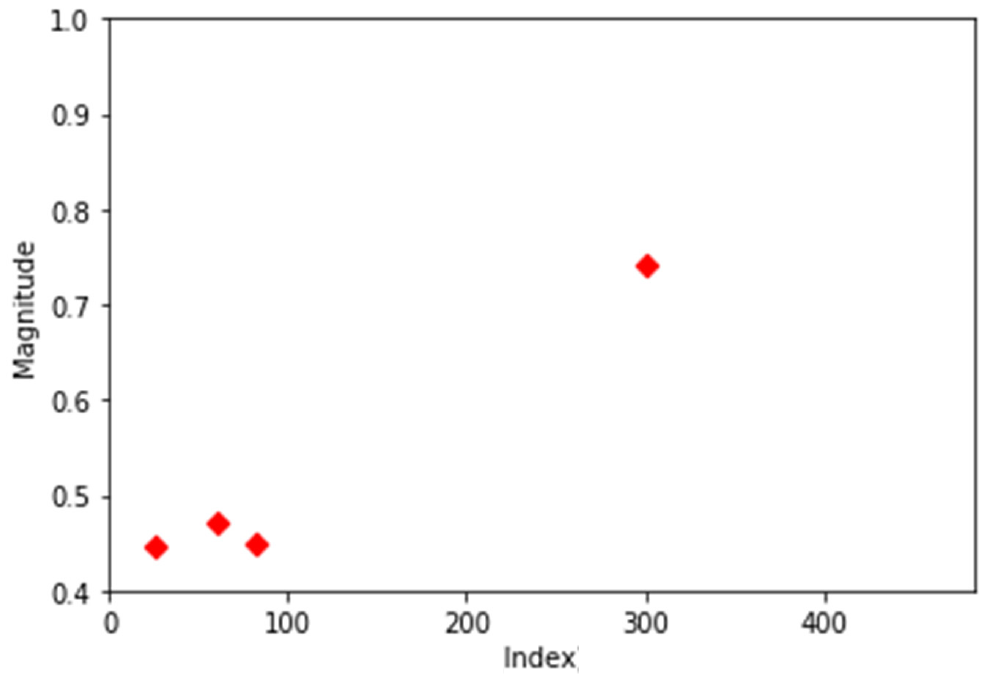
Figure 9. Center points of second-order error data.